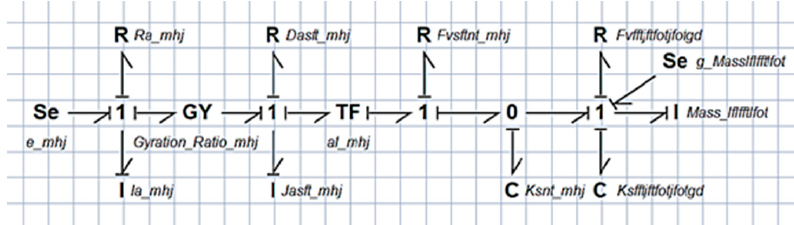
Figure 4. Composite model–bond graph using 20-sim.